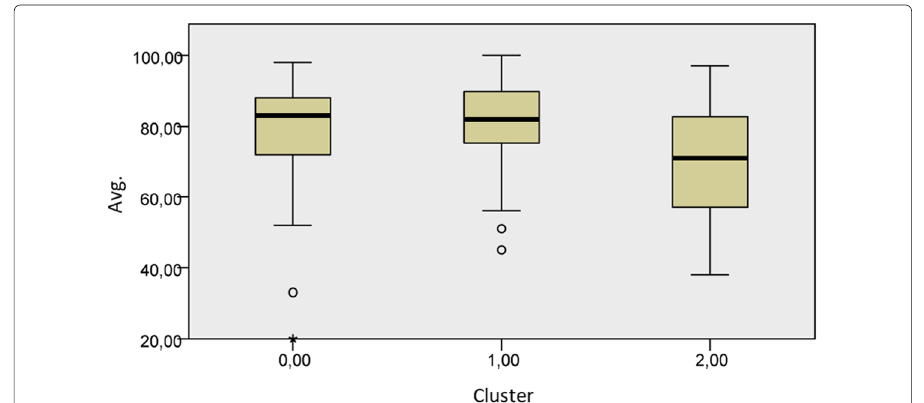
Fig. 10 Comparison among the 3 clusters. The difference between CL0 and CL1 and between CL0 and CL2 was not as significant as the difference between CL1 and